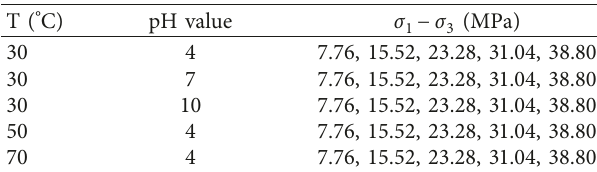
Table 2: Schemes of creep